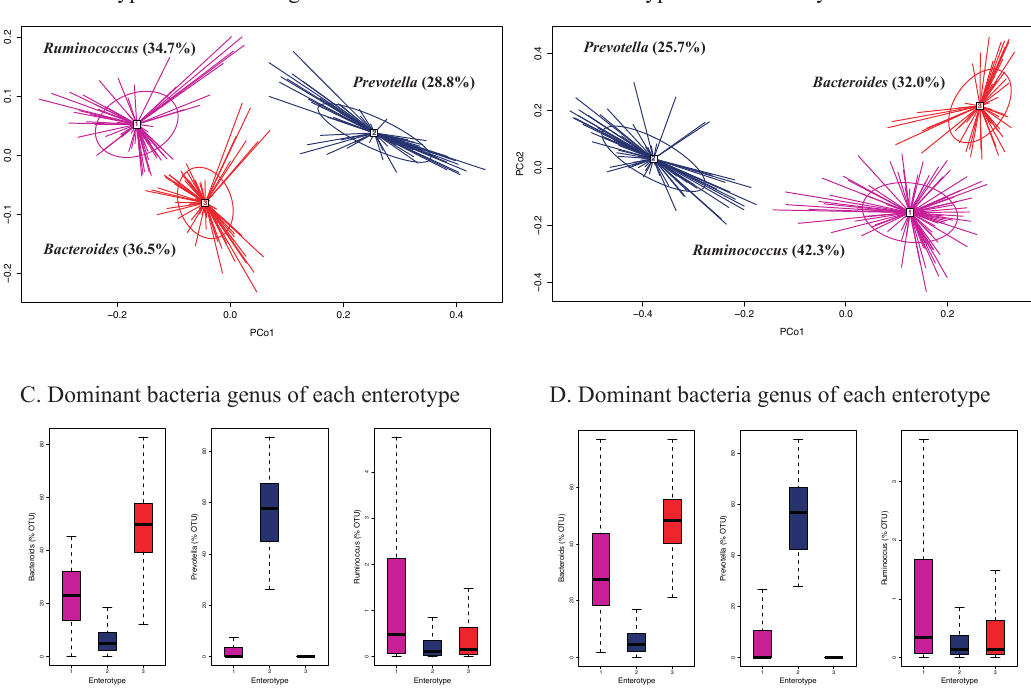
Figure 3. Enterotypes of gut microbiota in Korean adults of the NAS-IARC cross-sectional study ( n = 222 participants). Three enterotypes were identified by Principal Coordinates Analysis (PCoA) and k-means clustering based on ( A ) weighted UniFrac and ( B ) Bray-Curtis distance matrix ( β -diversity) of gut microbiota in the Korean adults; dominant bacteria genus of each enterotype— Bacteroides , Prevotella , and Ruminococcus based on ( C ) weighted UniFrac and ( D ) Bray-Curtis distance matrix; panels A and B show scores of PCo1 (Principal Coordinate) and PCo2 on the axes and each study participant’s ID is represented in the panels (legibility of ID numbers not required). Table 3. Difference 1 in the high α -diversity dietary pattern (Hi α DP) and intakes of food groups and nutrients among